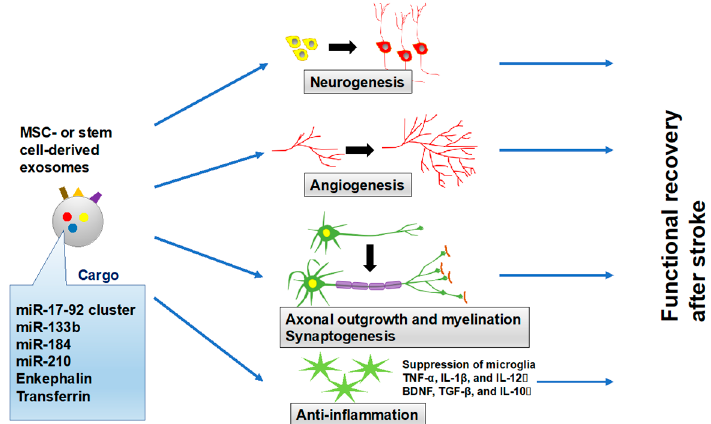
Figure 2. Effects of MSC-derived or stem cell-derived exosomes on stroke recovery. Exosomes derived from MSCs or stem cells show significant improvements of motor recovery through neurogenesis, angiogenesis, axonal outgrowth and myelination, synaptogenesis, and suppression of microglia, together with anti-inflammatory effects. MSC = Mesenchymal stromal cell.